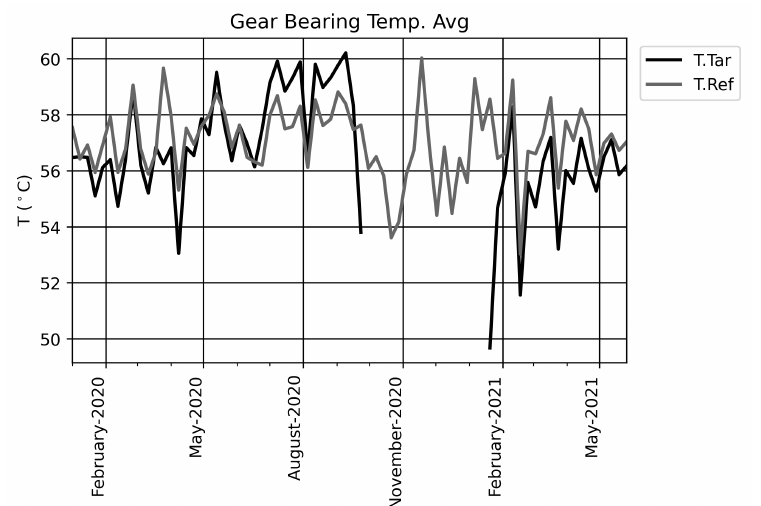
Figure 6. Gear bearing temperature